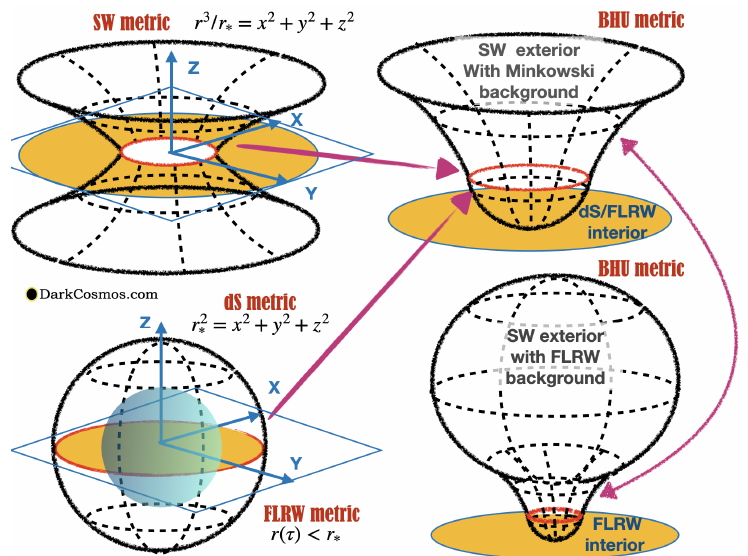
Figure A1. Representation of ds 2 = ( 1 + 2 Φ ) − 1 dr 2 + r 2 d θ 2 in polar coordinates embedded in 3D flat space. Yellow region shows the 2D projection coverage in the true ( x , y ) plane. In ( bottom left ) we show: deSitter (dS, 2 Φ = − r 2 / r 2 ∗ ) and FLRW ( r = r ( τ ) < r ∗ , blue sphere inside dS). In ( top left ), we show Schwarzschild (SW, 2 Φ = − r ∗ / r ). In the ( top right ), we show a BHU with dS (or FLRW) interior and SW exterior. More generally, the BHU solution has two nested FLRW metrics join by SW metric ( bottom right